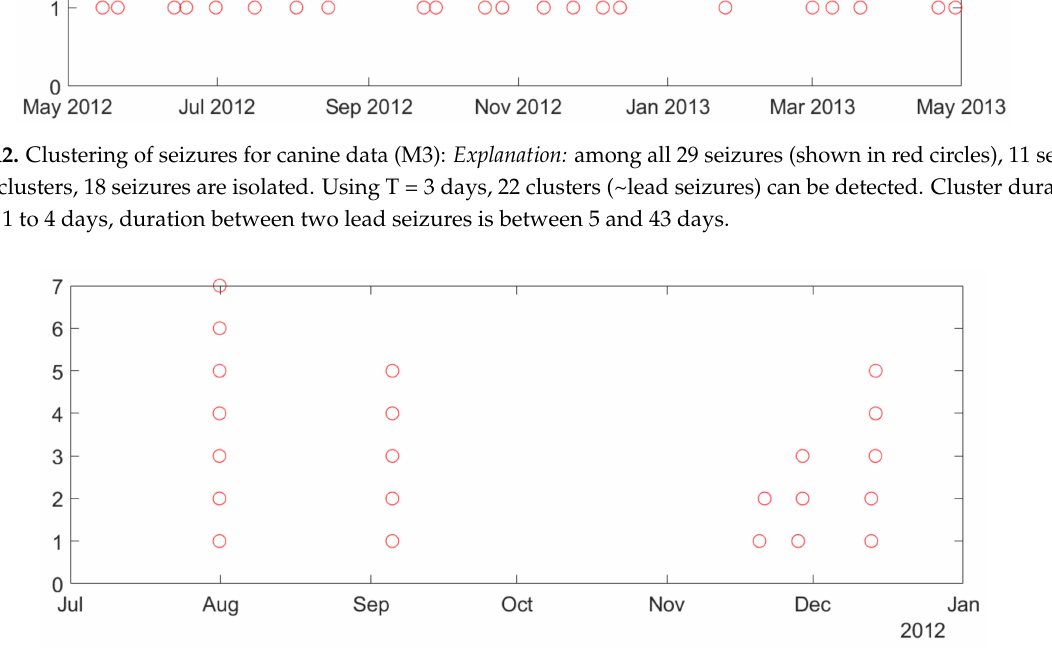
Figure A3. Clustering of seizures for canine data (P2): Explanation: among all 22 seizures (shown in red circles), All 22 seizures occur in clusters. Using T = 3 days, 5 clusters (~lead seizures) can be detected. Cluster duration is between 0 to 1 days, duration between two lead seizures is between 8 and 75